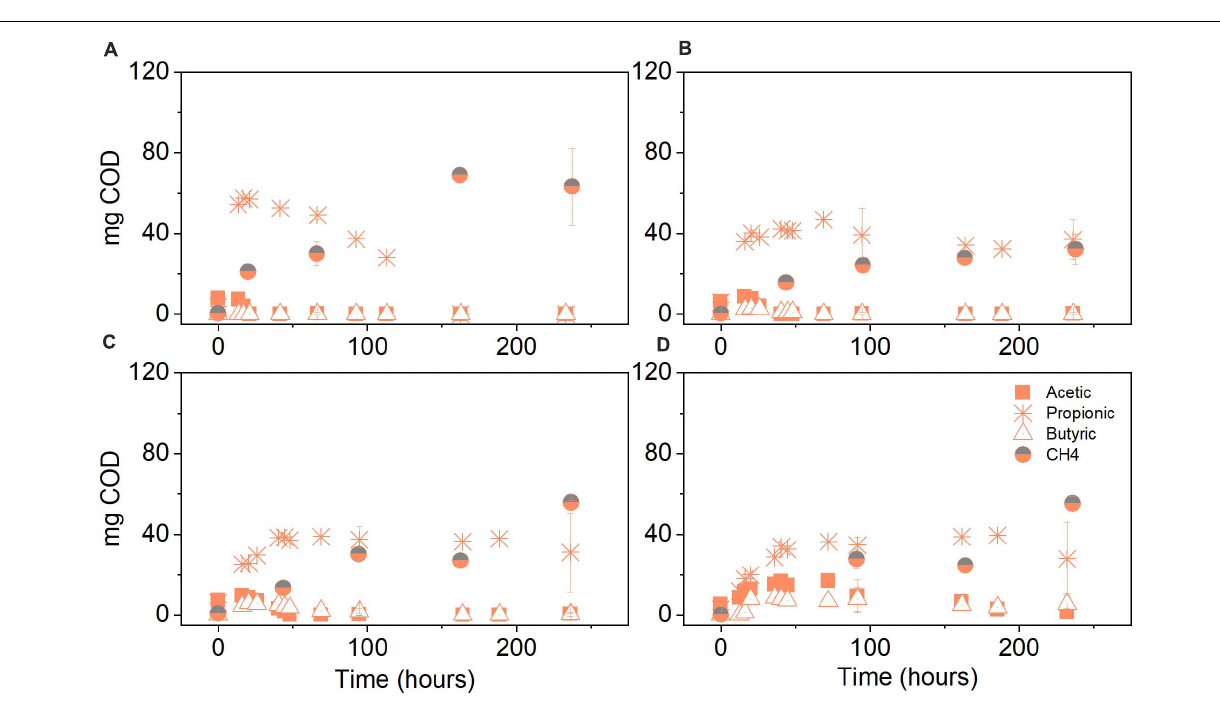
FIGURE 4 | Volatile fatty acid (VFA) and CH 4 production (mg COD) over time for the glucose conversion experiments using original inoculum at initial pCO 2 of (A) 0.3 bar, (B) 3 bar, (C) 5 bar, and (D) 8 bar. Pressure corresponds to initial values before equilibrium. Data points represent experimental data. Bars represent the standard deviation of three biological replicates measured at the beginning, middle, and end of the